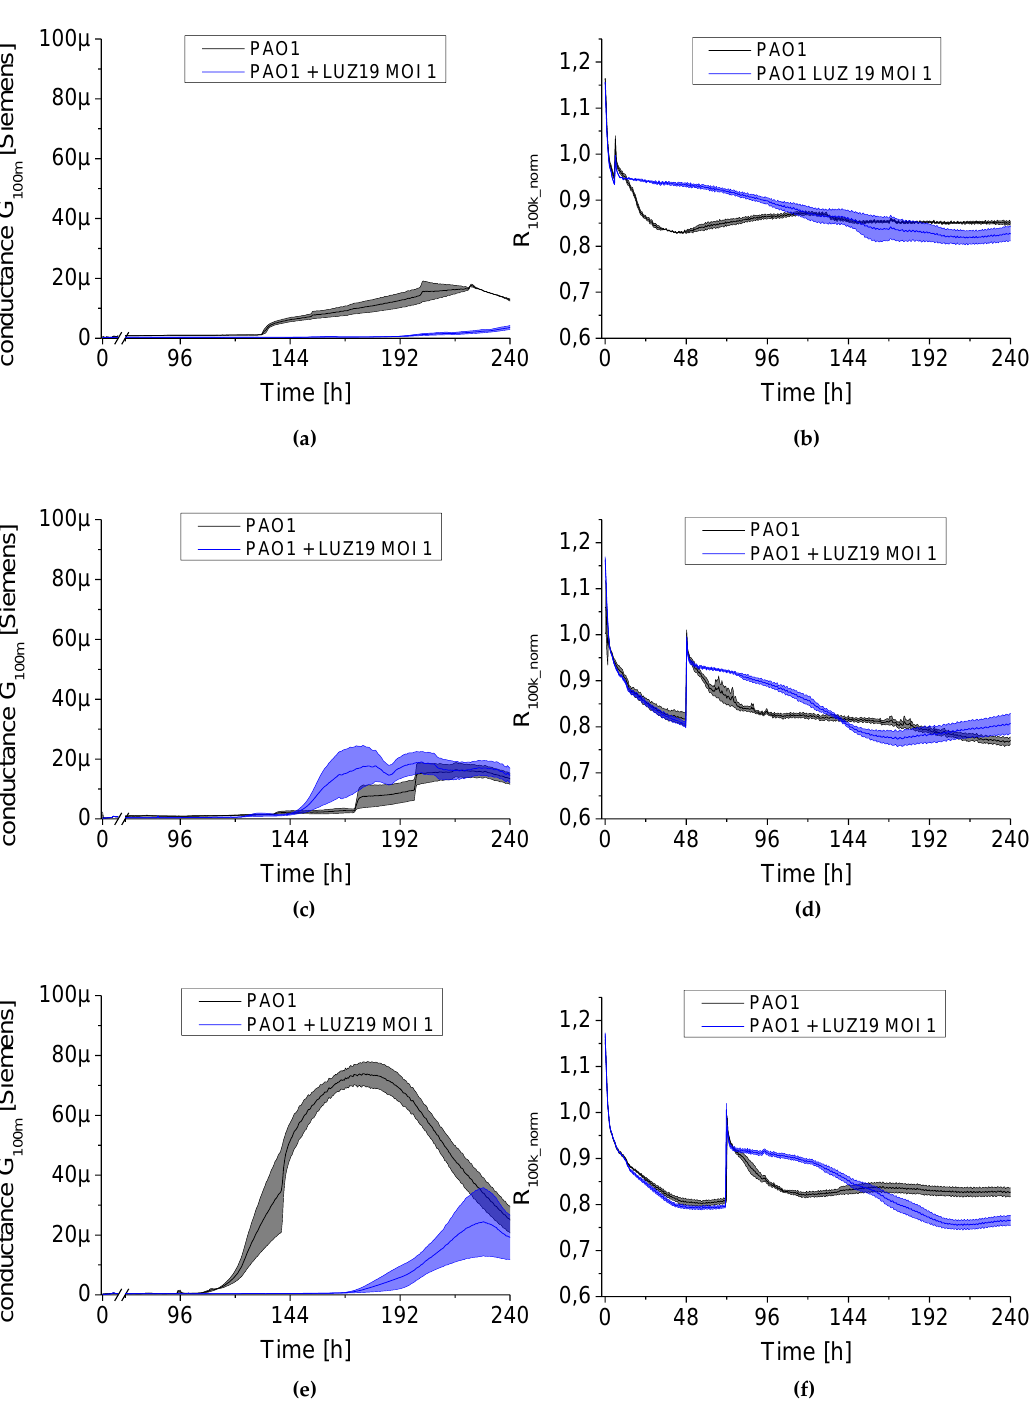
Figure 9. The changes in conductance G100m (left panel) and resistance R100k_norm (right panel) measured by QTF sensors during phage LUZ19 treatment of PAO1 biofilm at MOI = 1. Phage was applied at the 6th ( a , b ), 48th ( c , d ) and 72nd ( e , f ) hour of biofilm culture. In the right panel, for each variant, a peak appears, which is associated with the transfer of QTF sensors to new medium containing an appropriate concentration of viral particles. Data are expressed as mean of conductance G100m ± SD and resistance R100k_norm from three independent experiments.